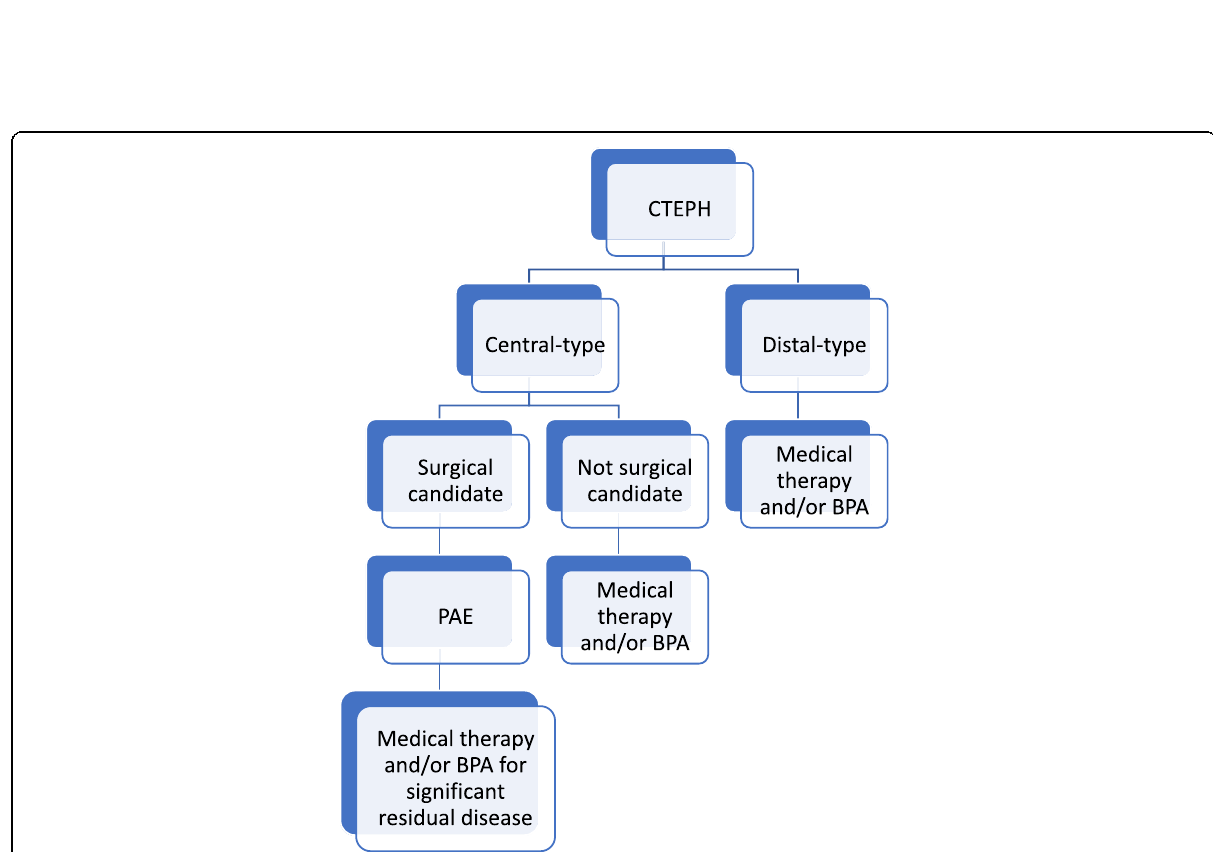
Fig. 23 Treatment algorithm of CTEPH. Diagram demonstrates an algorithm for the treatment of central-type and distal-type